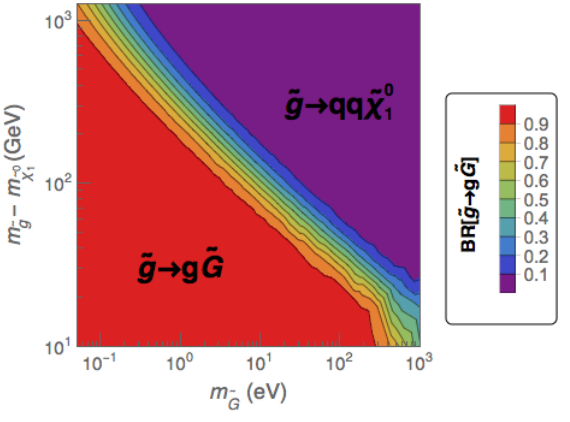
Figure 1 . Variation of BR(